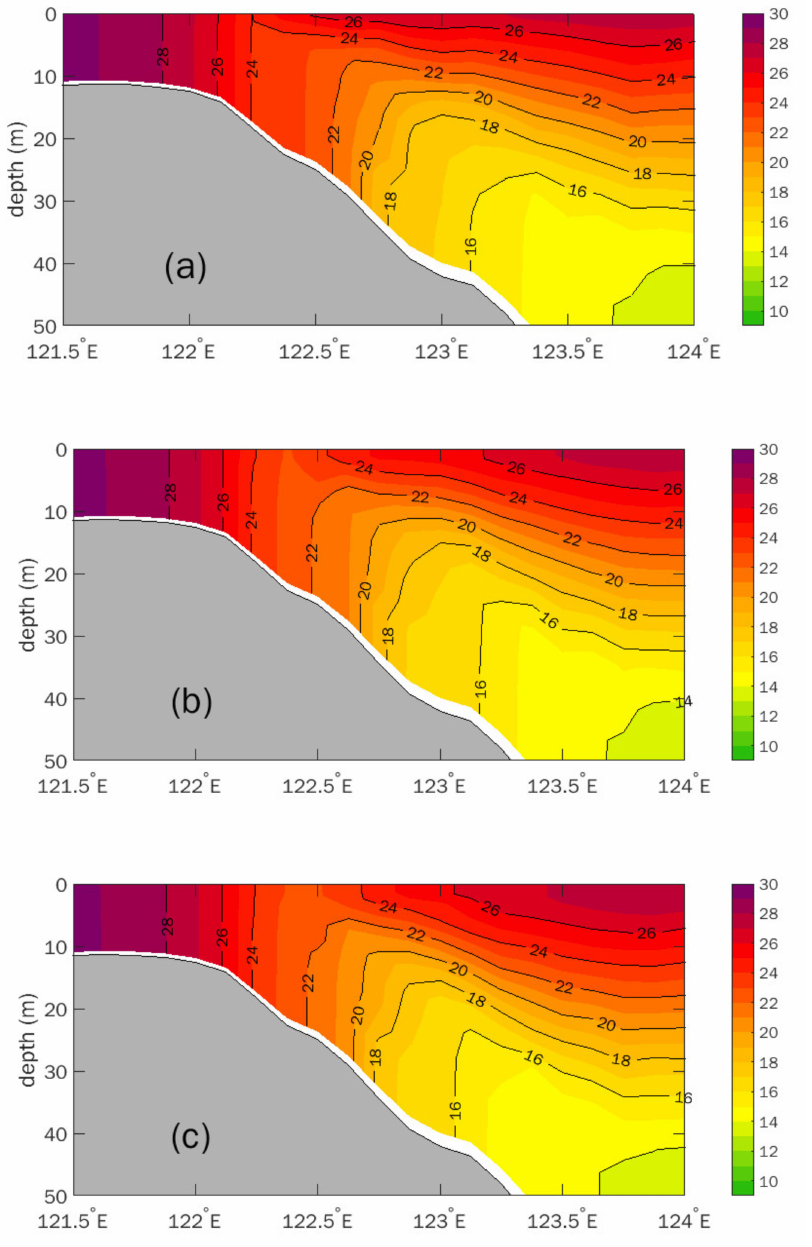
Figure 11. Simulated vertical temperature along 33.5 ◦ N section in ( a ) Exp.nw, ( b ) Exp.cw, and ( c )